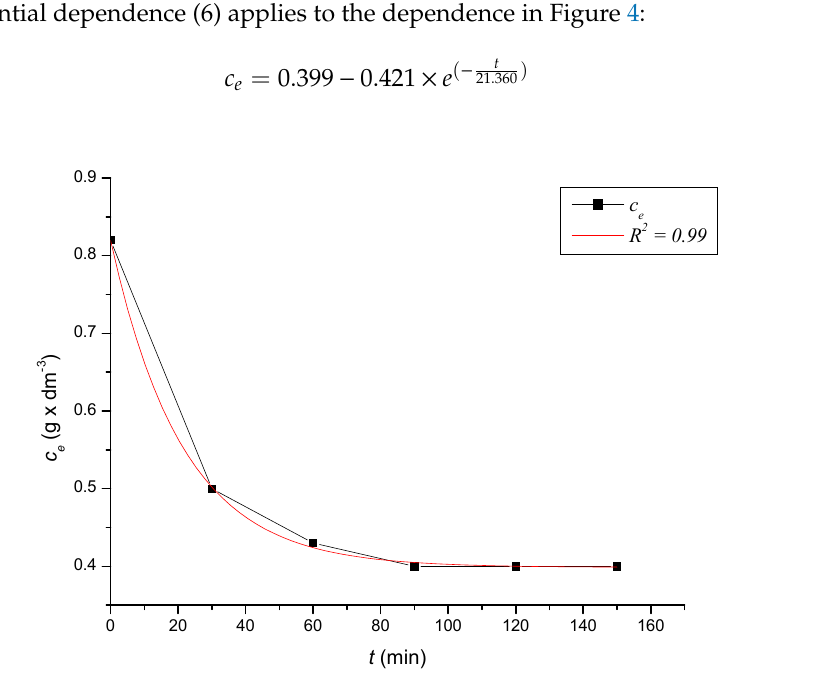
Figure 4. The kinetic course of reducing the concentration of Fe 3+ cations in a solution with an initial concentration of 0.82 g × dm −3 by the action of clinoptilolite.